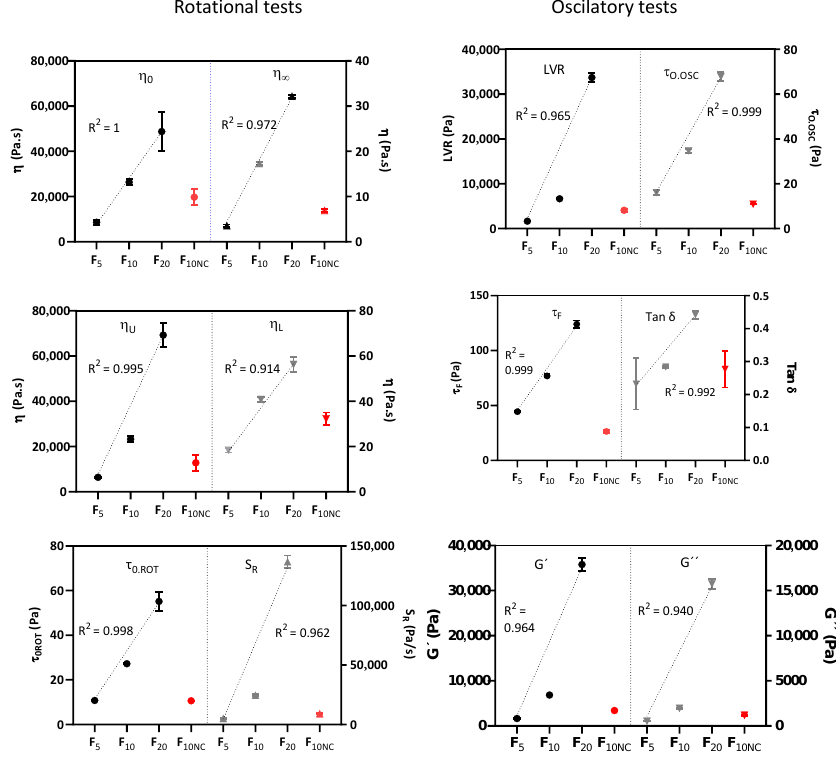
Figure 6. Specificity results. Results are expressed as mean ± SEM. A 6 < n < 36 was used. To evaluate selectivity, the ability of the methods to accurately identify distinct formulations, three pairwise statistical comparisons were performed: (i) F 10 vs. F 5 ; (ii) F 10 vs. F 20 and; (iii) F 10 vs. F 10NC .